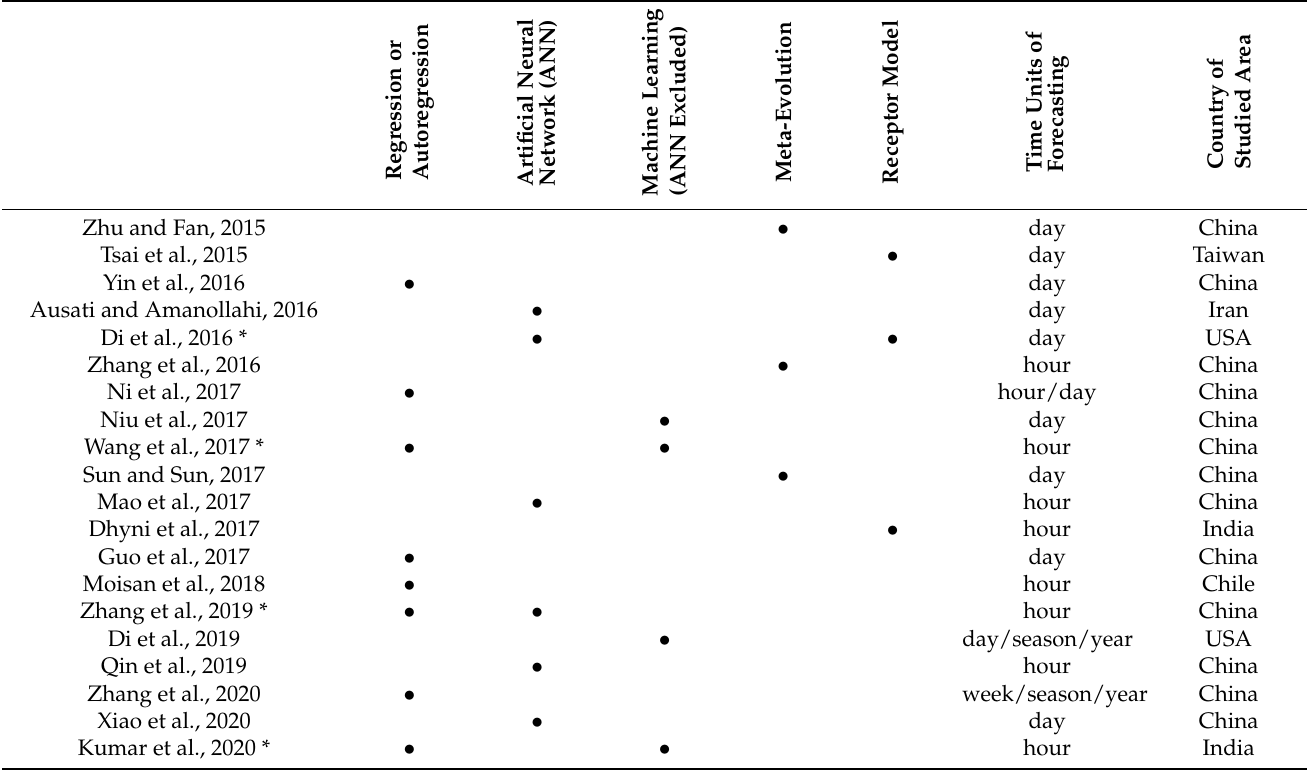
Table 1. Comparison of recent works on PM 2.5